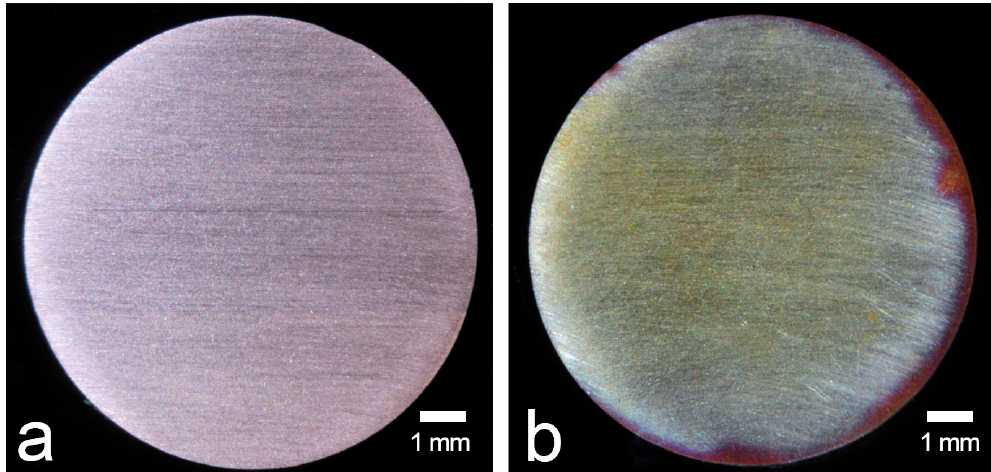
Figure 1. Copper specimens: ( a ) UH, unheated copper; ( b ) HT, heated copper. Digital photographic system: original magnification ×8.